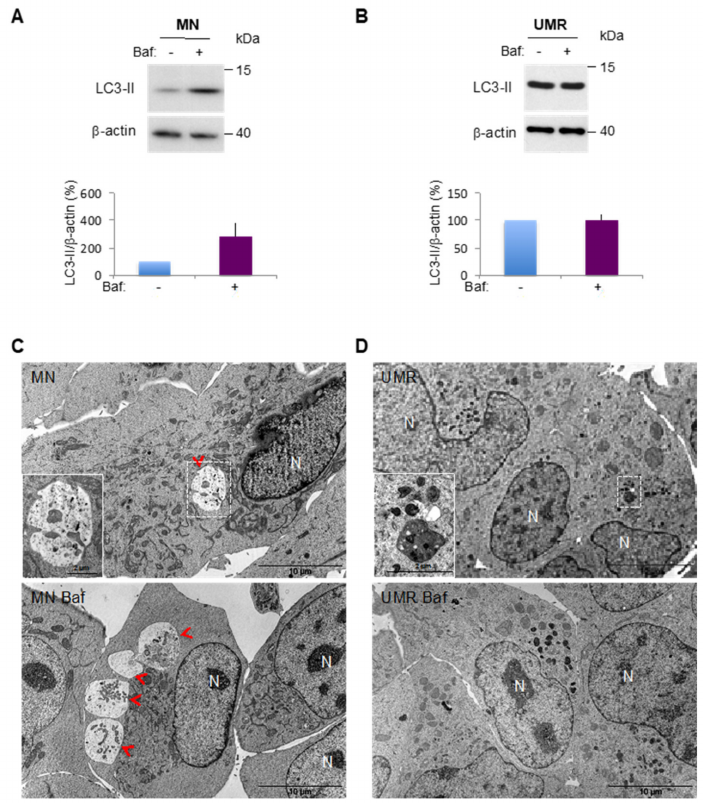
Figure 1. Selection of Osteosarcoma (OS) cell lines with di ff erent autophagic profiles. ( A , B ) LC3-II expression was analyzed by Western blot in the MNNG / HOS (MN) and UMR-106 (UMR) cell lines,